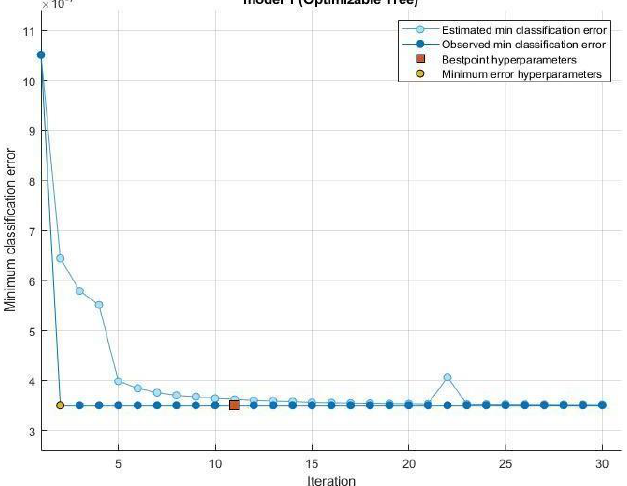
Fig. 18. SSDP flood minimum classification error of bayesian based optimized tree